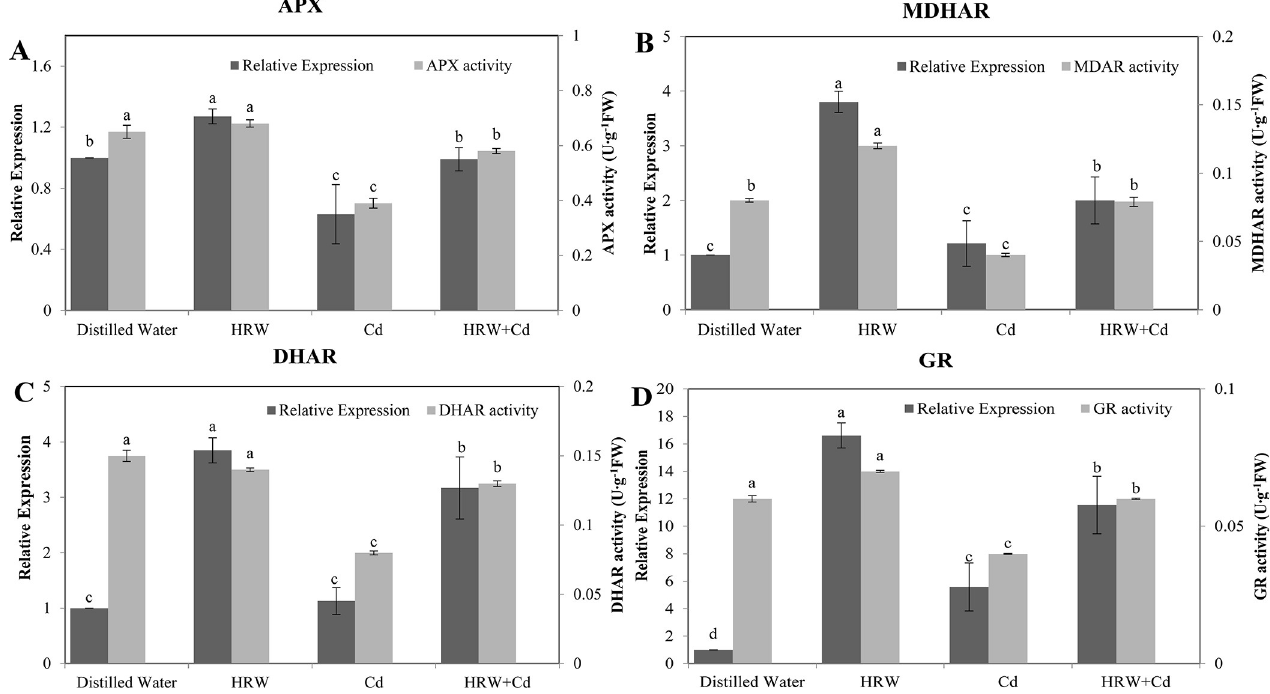
Fig 6. Effects of HRW on Ascorbate-glutathione cycle related enzyme activity and gene expression during adventitious root development in cucumber under Cd stress. The primary roots were removed from hypocotyls of 5-day-old cucumber seedlings. Explants were incubated for 2 d with distilled water (control), 50%HRW, 1 μ M Cd(NO 3 ) 2 , 50%HRW+1 μ M Cd(NO 3 ) 2 . The relative enzyme expression and activity of APX ( A ), MDHAR ( B ), DHAR ( C ) and GR ( D ) were expressed as mean ± SE, respectively. Bars not sharing the same letters were significantly different ( P < 0.05).